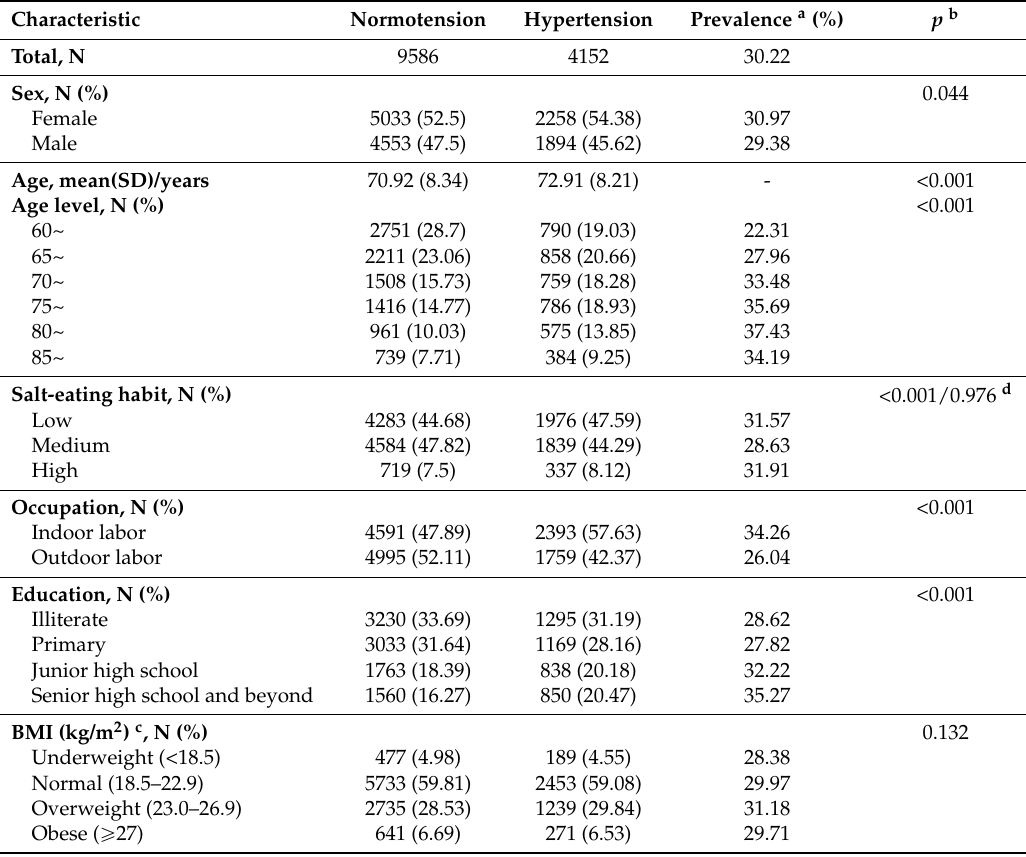
Table 1. Basic characteristics of 13,738 participants according to the status of